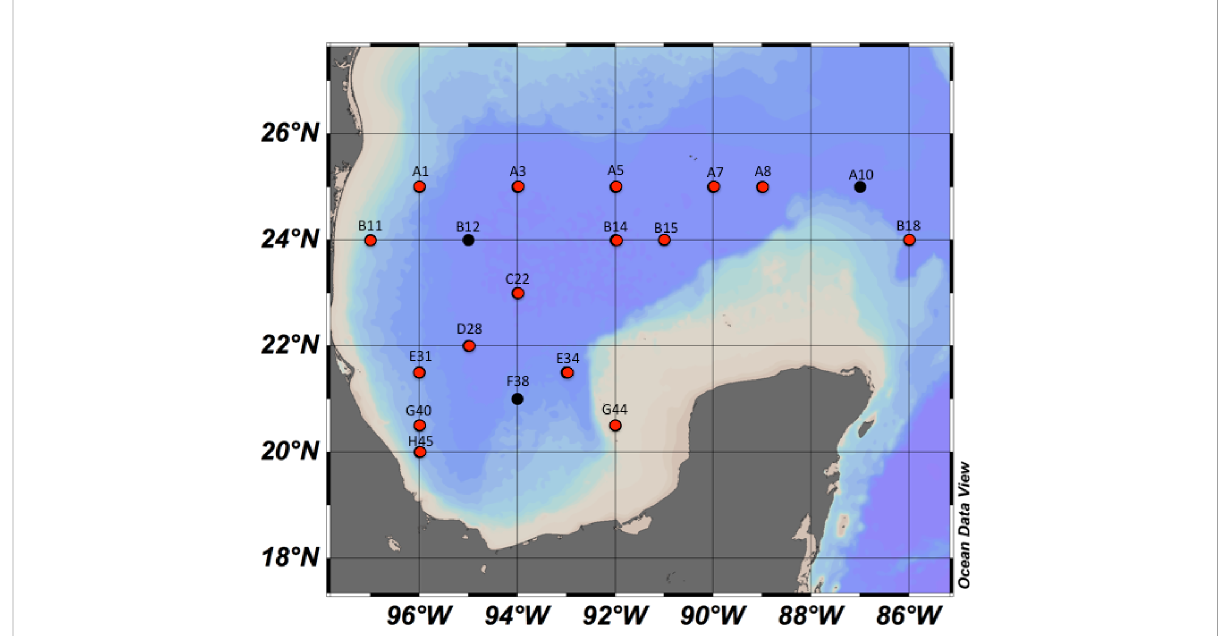
FIGURE 2 Water and sediment sampling localities in the SGoMex, for the XIX-4, XIX-5 and XIX-6 oceanographic cruises. Black dots indicate the locaties were only water was collected and red dots where water and/or sediment were